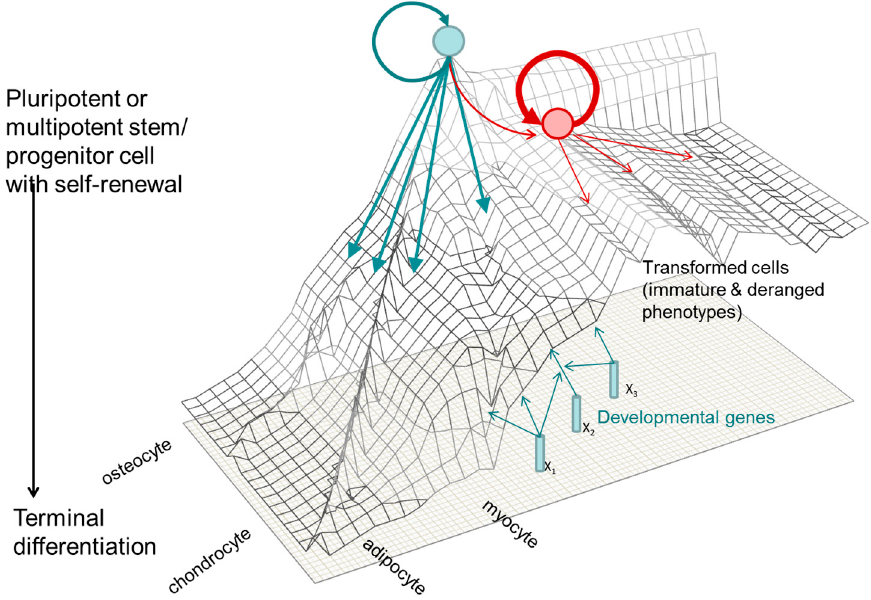
Figure 2. The epigenetic landscape metaphor for cell transformation. The model presents a progenitor/tissue stem cell with an early multipotent phenotype and self-renewal capacity (circular arrow), as determined by the expression state/profile of a host of genes within a developmental gene network ( X 1 , X 2 , X 3 , . . . , X n ), which is represented by the horizontal plane below the landscape. Three example genes within the larger network are shown, as they might appear at a particular stage of cell development. The gene regulatory interactions are the “forces” that shape the hills and valleys in the epigenetic landscape, propelling the progenitor toward development while constraining transitions among available phenotypes to particular channels (green arrows indicate normal progression toward separate developmental fates). A series of gene network states, with changes in expression of its individual genes, determine the topography of the development landscape. In this model, cell transformation is depicted as a diversion from the predetermined developmental channels, where self-renewal capacity is greatly diminished, into gene network expression states that create alternate, immature phenotypes with limited developmental potential and increased and perpetual self-renewal capacity (red arrows indicate abnormal progression due to transformation events).